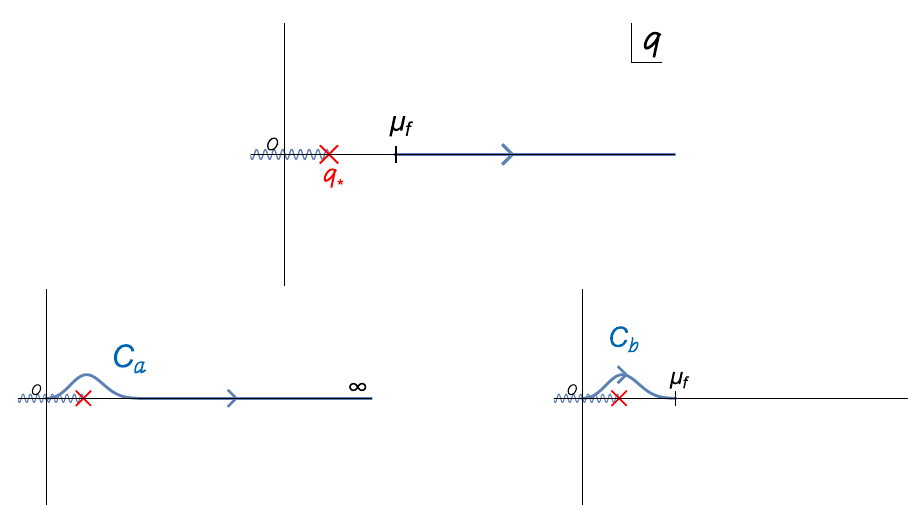
Figure 13 . Contour C a and C b in the complex q -plane. q (cid:3) shows the singular point of (cid:11) V ( q 2 ).